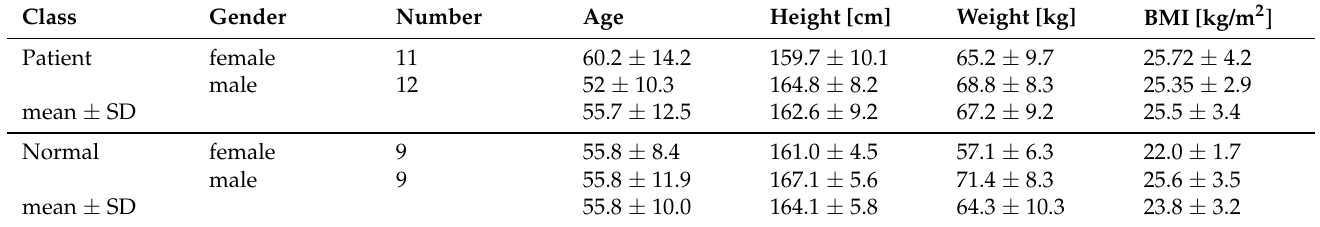
Table 1. Human subject (patients with hip osteoarthritis (OA) and healthy subjects (Normal)) information in this experiment: gender, age, height, weight, and body mass index